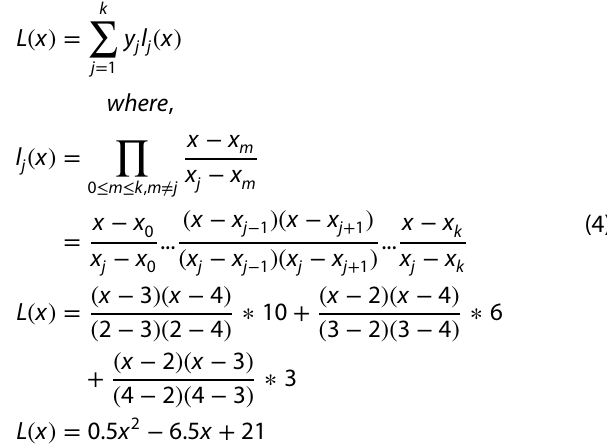
Table 3 Percentage of mixing completion for individual shift- movements Shift movements